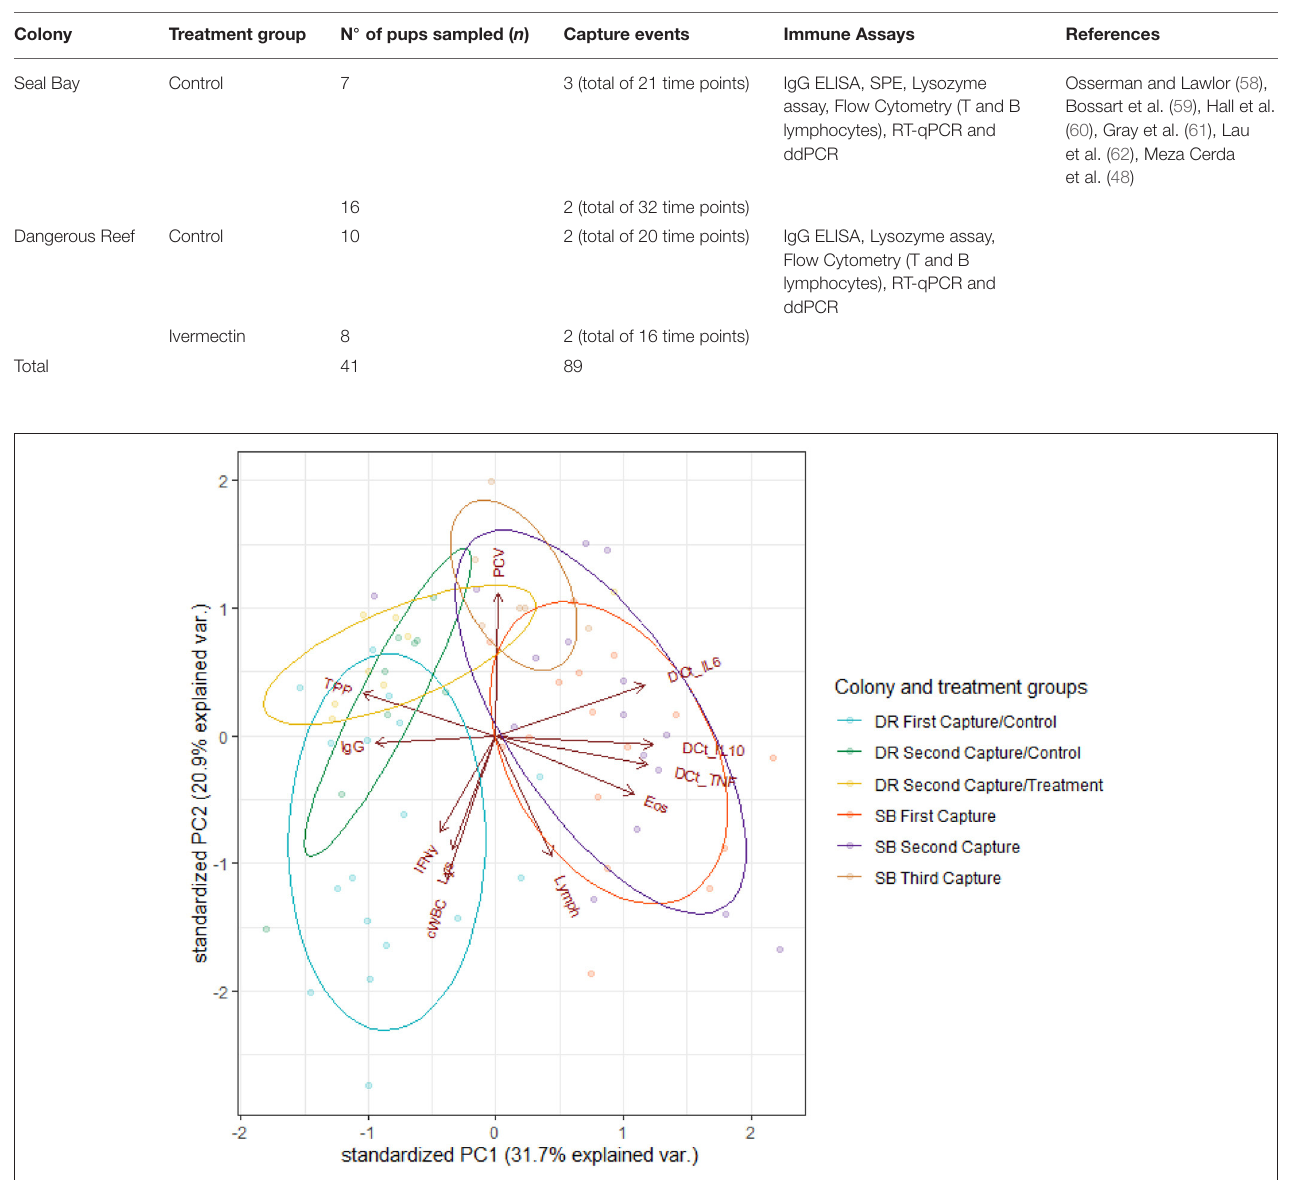
when the SB control and the DR control group were